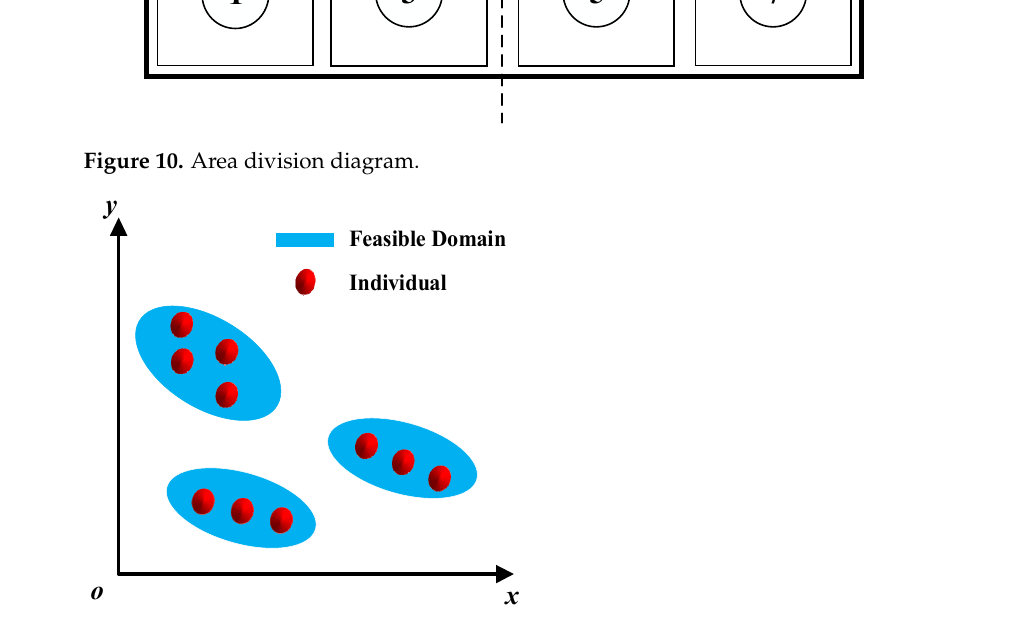
Figure 10. Area division diagram.